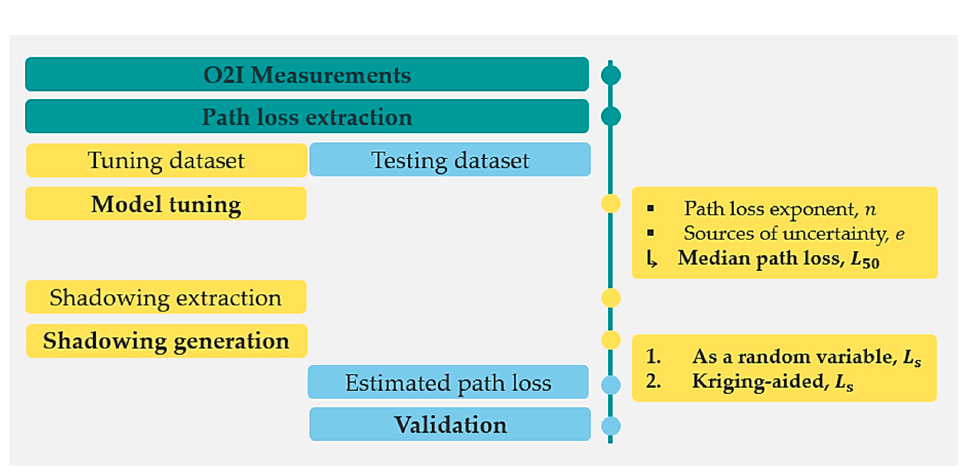
Figure 4. Channel model methodology.